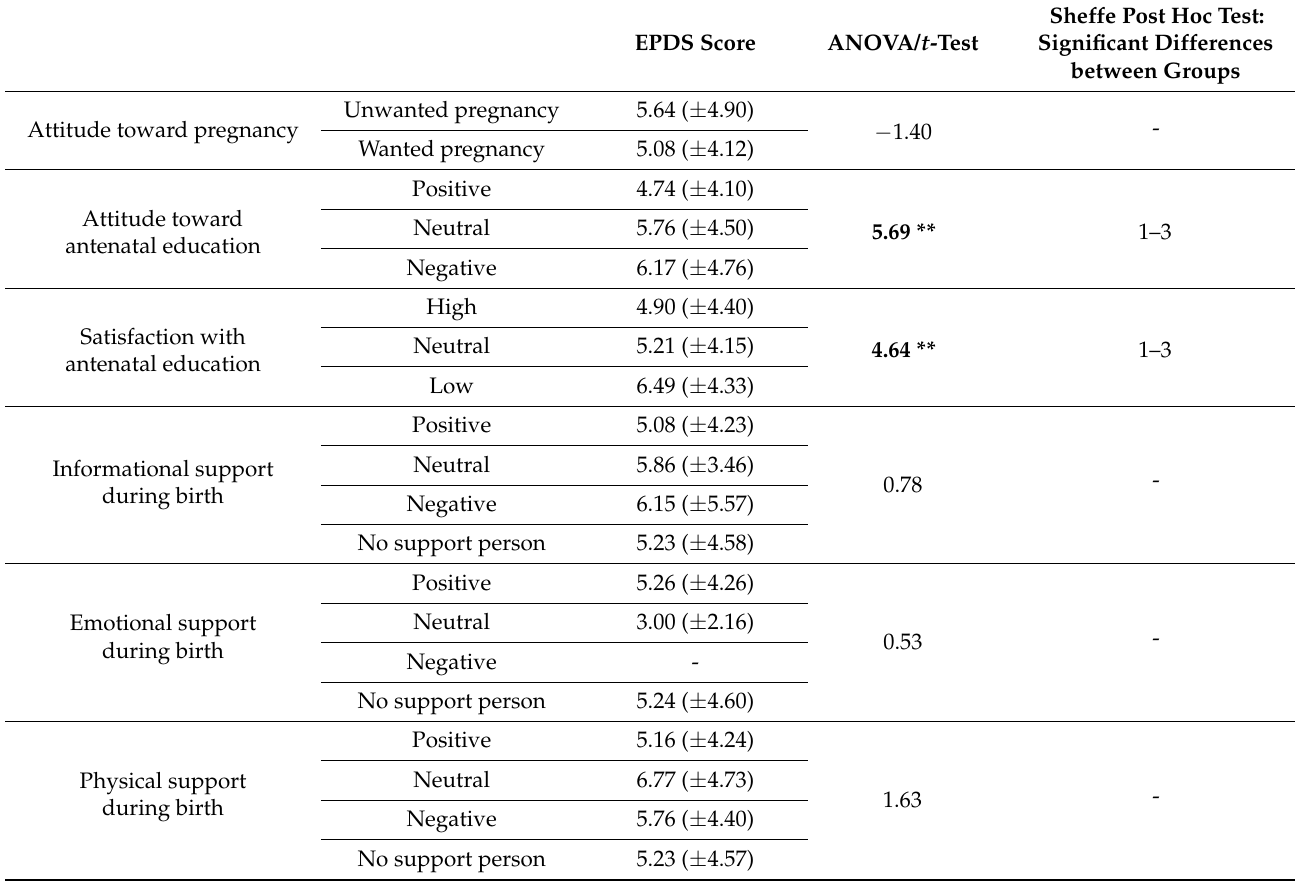
Table 3. Analysis of variance for differences in total EPDs scores between different groups of participants according to antenatal education, attitudes toward pregnancy, and support during birth.